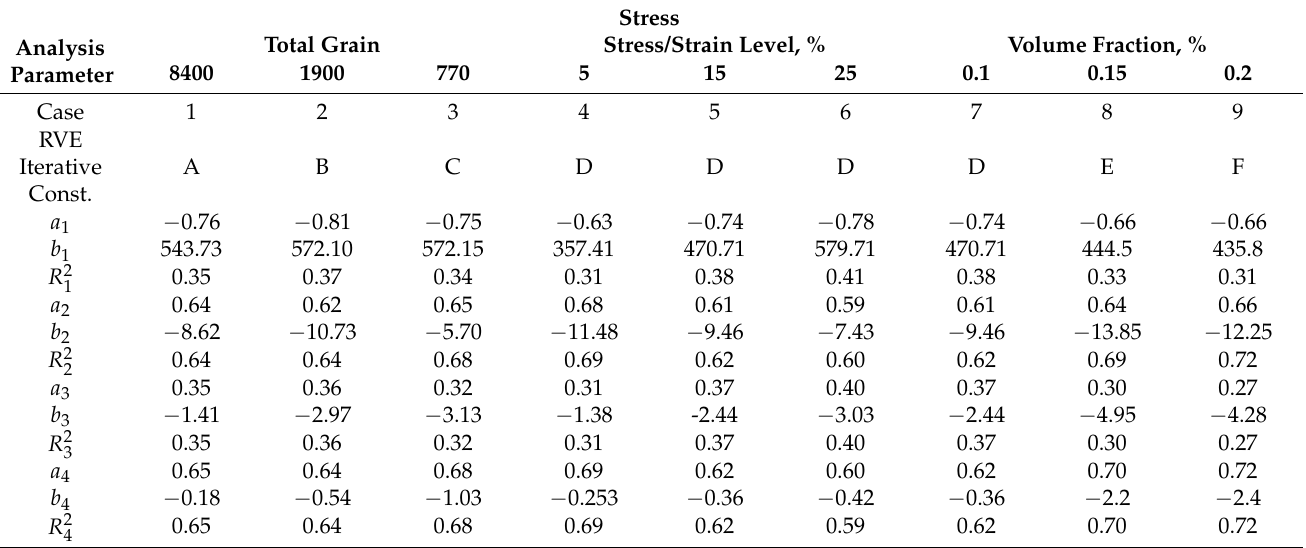
Table 3. Constants a m , b m , and R 2 m (m = 1, 2, 3, 4) for the ferrite phase of linear equation with stress condition by the proposed iterative